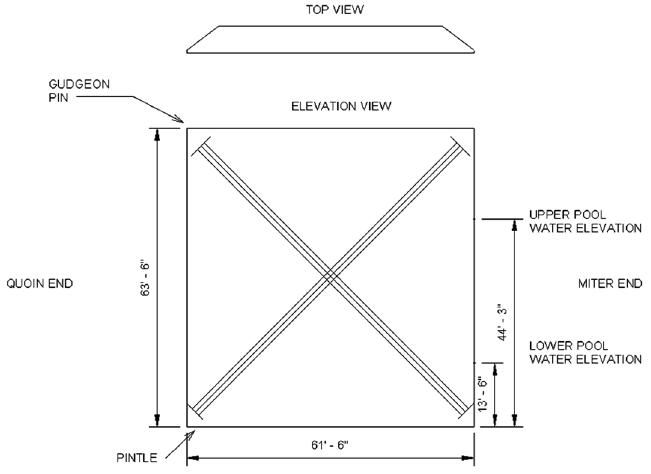
Figure 2. Upstream elevation and top view of a lock gate (Greenup Lock and Dam, Ohio